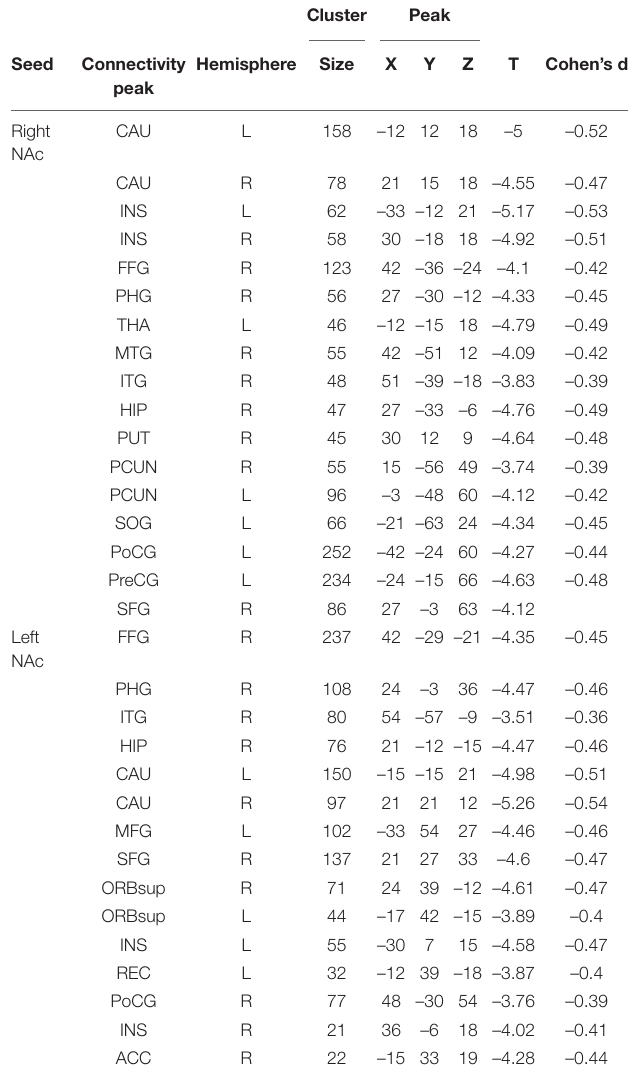
TABLE 2 | Resting-State Functional Connectivity (RSFC) Group Comparisons (MDD vs. HCs).